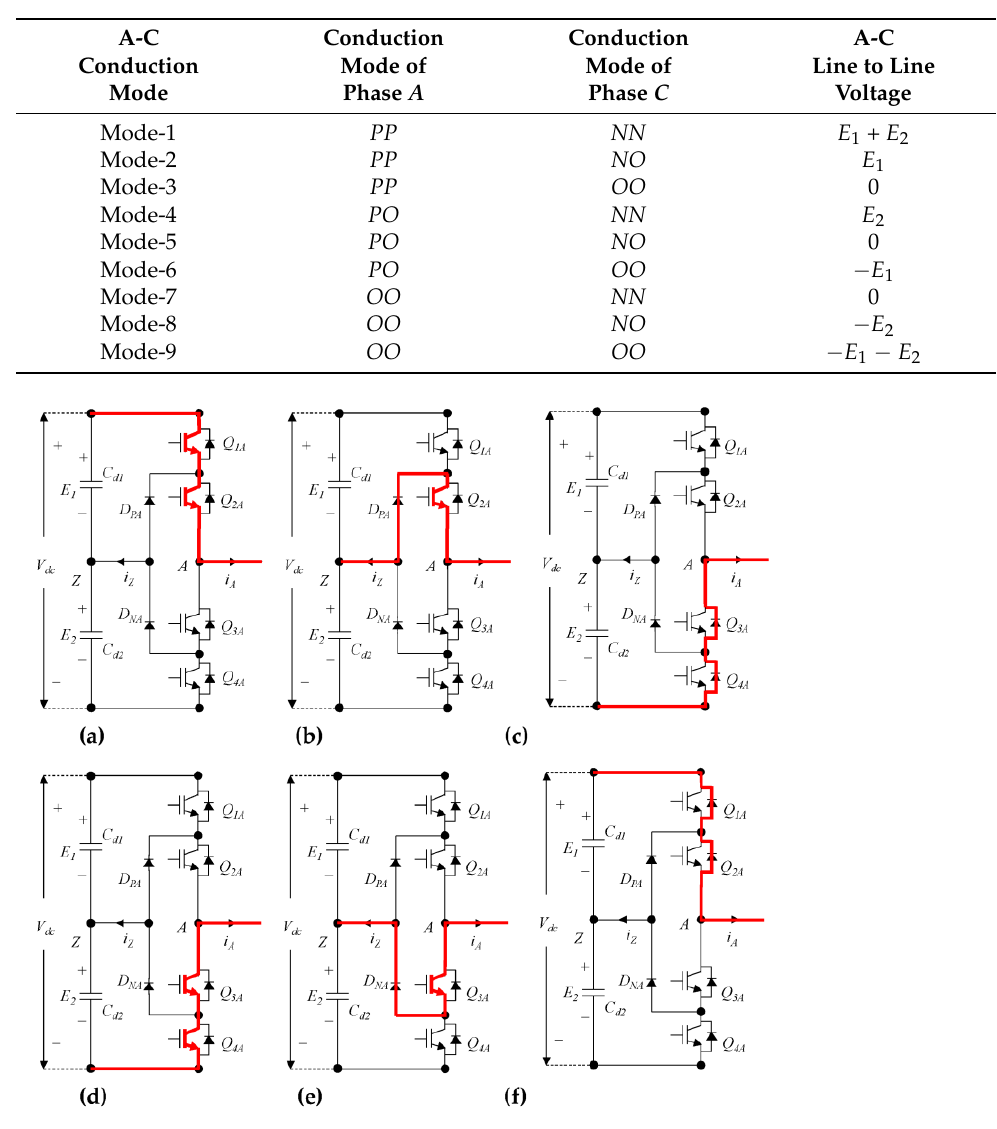
Table 4. Conduction mode from phase A to phase C.